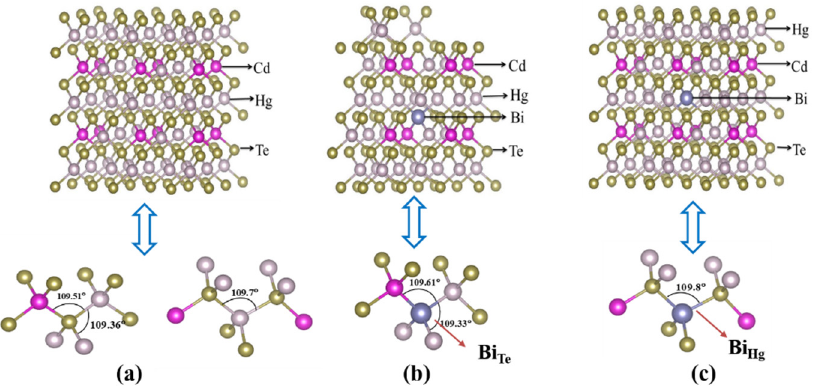
Figure 1. The 2 × 2 × 2 supercell for ( a ) undoped Hg 0.75 Cd 0.25 Te, ( b ) the in situ impurity Bi Te in Hg 0.75 Cd 0.25 Te, and ( c ) the in situ impurity Bi Hg in Hg 0.75 Cd 0.25 Te.